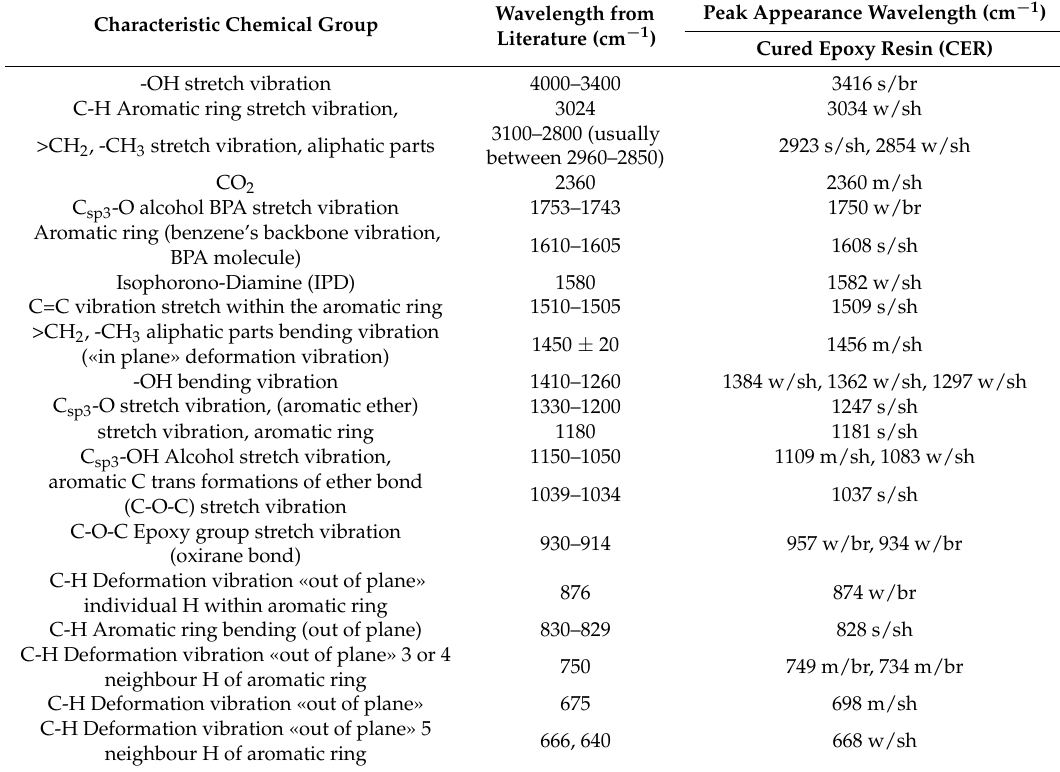
Table 8. FT-IR spectra characteristic peaks from the epoxy resin (the